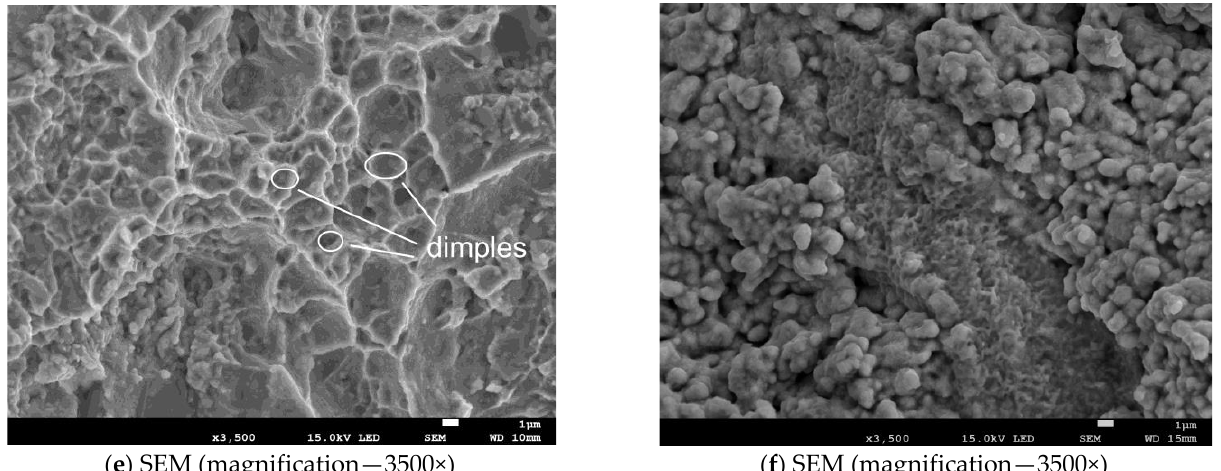
Figure 14. SEM image of fracture surface after tensile test (at 750 ◦ C and 900 ◦ C) and prior isothermal holding at 750 ° C for 3 h ( c , e ) and at 900 ° C for 3 h ( d , f ); LM microstructure from the tensile specimen ( a , b ).